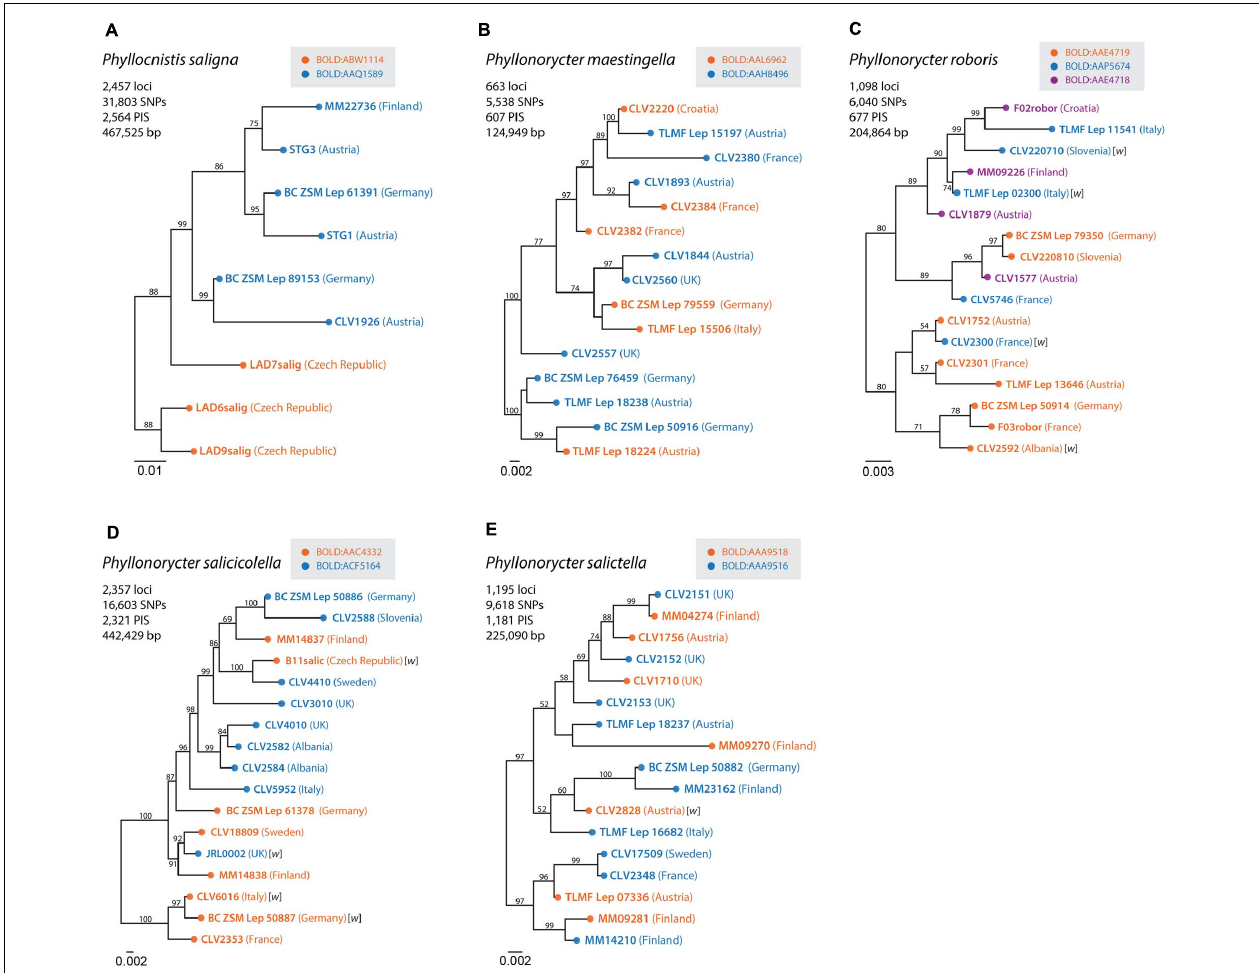
FIGURE 5 | Maximum likelihood (ML) phylogenies of (A) Phyllocnistis saligna , (B) Phyllonorycter maestingella , (C) Phyllonorycter roboris , (D) Phyllonorycter salicicolella , and (E) Phyllonorycter salictella . ML trees were inferred from the concatenated ddRAD data with RAxML. Bootstrap values are indicated near the branches and only > 50% are shown. Colors used for the ddRAD sequences match the clade assignment based on DNA barcoding data. Fourteen samples infected by Wolbachia are indicated in the trees marked with w between